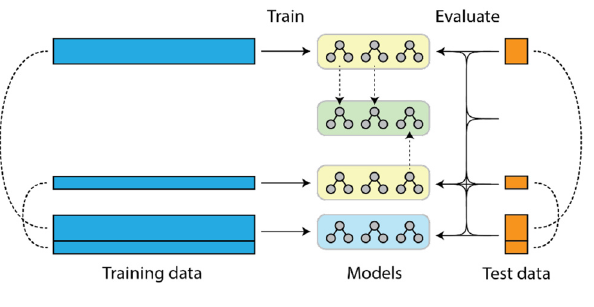
Figure 3: Training and evaluation of the FL model.